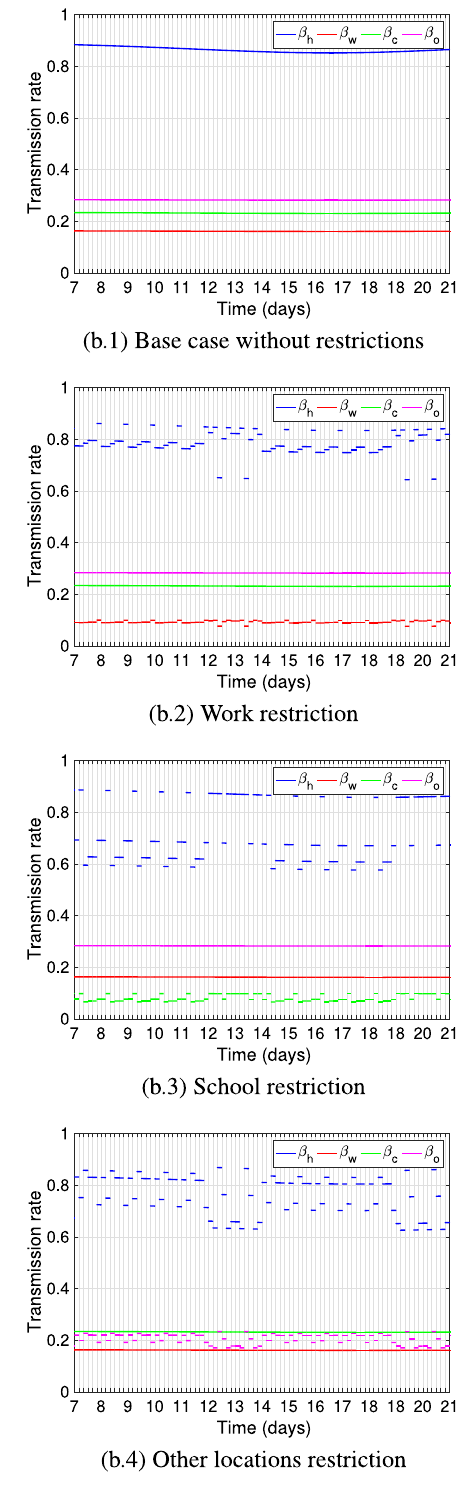
Figure 4. The figures ( a.i ), i = 1–4 depict the number of active cases ( A ( t ) + I ( t ) )—the infectious population— at each location: home ( h , blue), work ( w , red), school ( c , green) and other ( o , pink); as well as the total number of active cases ( T , black). The curves are pictured for a base case without restrictions and under one restrictions at a time to attend a specific location: ( a.1 ) base case, ( a.2 ) work, ( a.3 ) school, ( a.4 ) other. For each case, the figures ( b.i ), i = 1–4 show the respective transmission rates at each location, pictured for time blocks within each day, from day 7 to day 21. The restrictions are obtained by reducing the parameters α x and α i x , x ∈ { w , c , o } , by: 25% for work, 73% for school, 30% for other activities. The parameter values used are as in Table